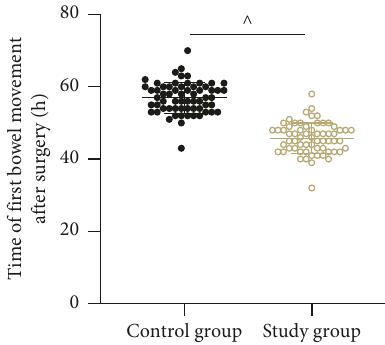
Figure 3: Comparison of time to postoperative first bowel movement within the two groups (h). ^ represents a significant difference between the two